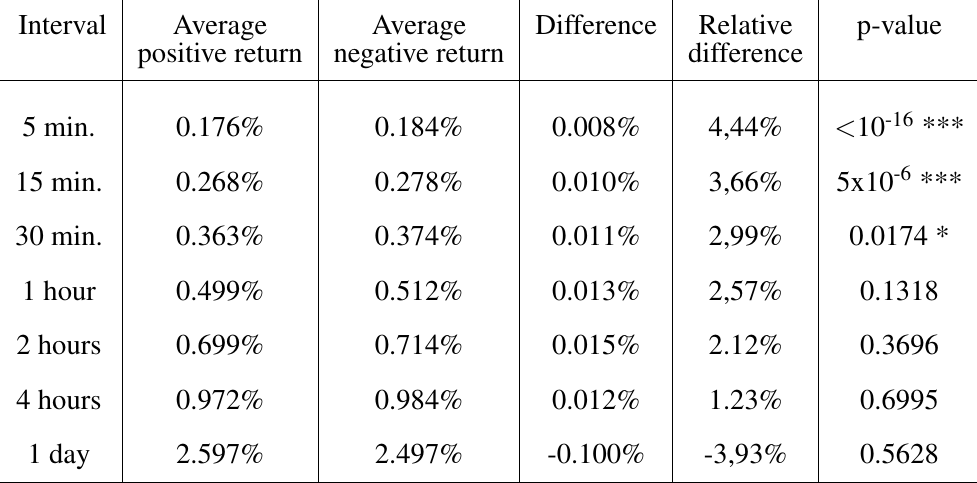
Table 2. Average differences between positive and negative returns at different